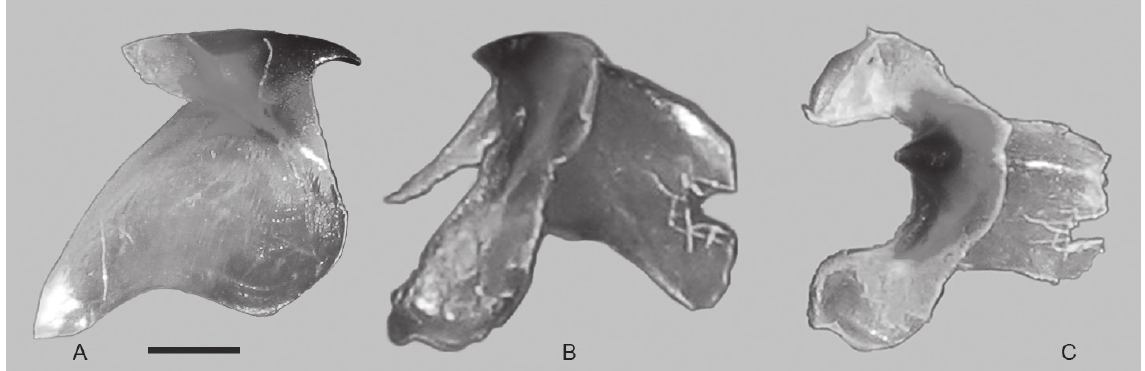
Fig. 5. Beaks of Sepiola boletzkyi sp. nov., paratype, ♀, ESFM-CEP/1994-2. A . Upper beak, lateral view. B . Lower beak, lateral-oblique view. C . Lower beak, upper (= ventral) view. Scale bar =